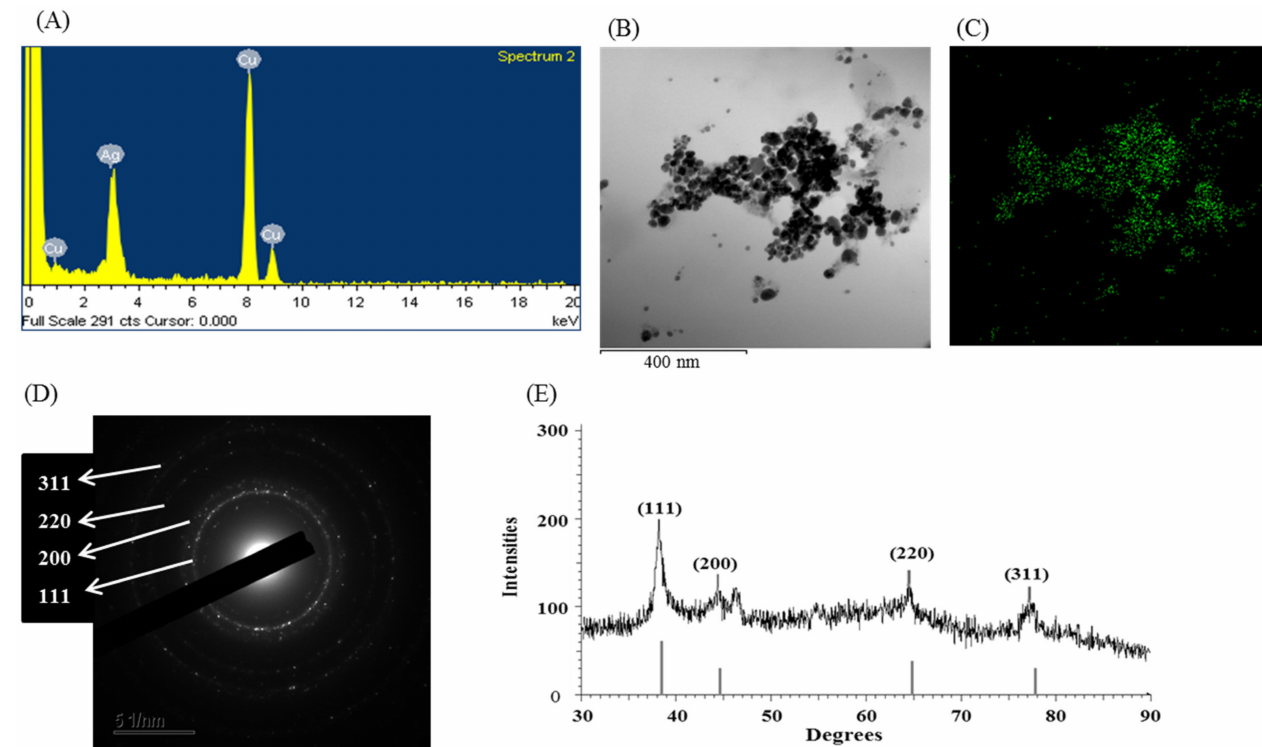
Figure 3. EDX spectrum of synthesized AgNPs ( A ), TEM image used for mapping ( B ), distribution of silver in elemental mapping ( C ), SAED pattern ( D ) and X-ray diffraction pattern ( E ) of Massilia sp. MAHUQ-52 mediated synthesized AgNPs. Table 1. The number and percentage of chemical elements present in EDX spectrum of Massilia